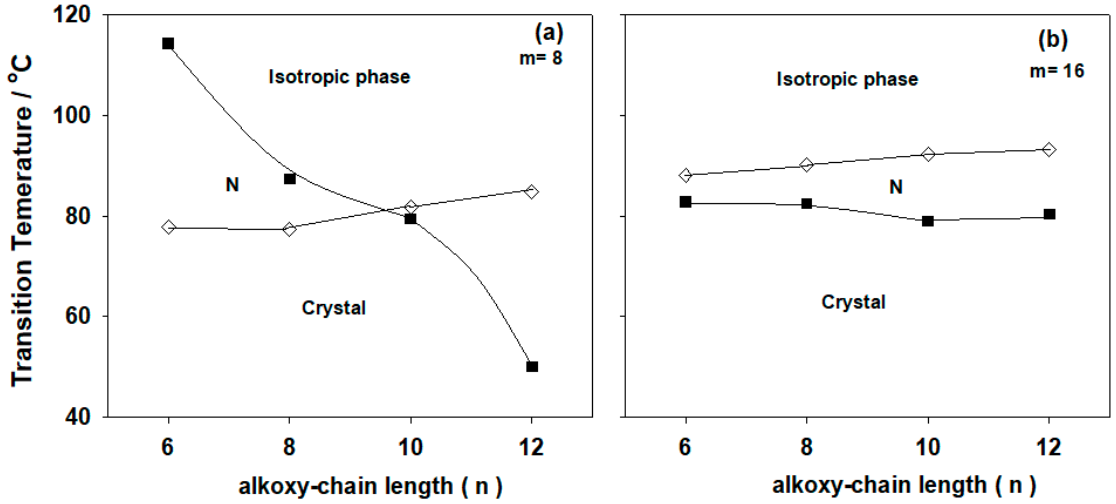
Figure 3. Dependence of the alkoxy-chain length of the acid component ( n ) of the lateral Cl azopyridines ( II m ) on the mesophase behavior of the 1:1 supramolecular hydrogen-bonded complexes ( a ) m = 8; ( b ) m = 16.